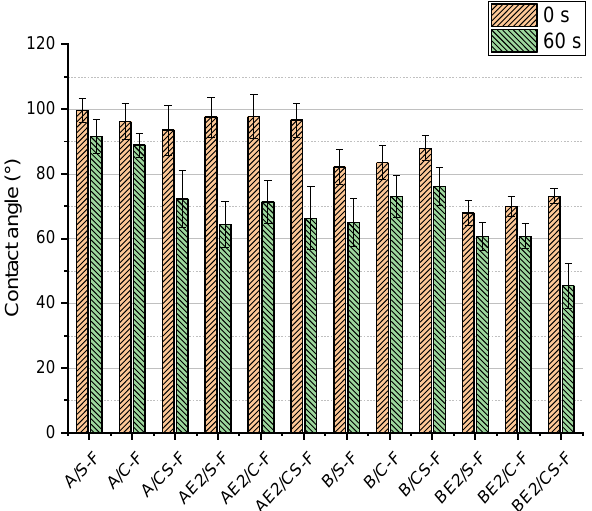
Figure 7. Contact angle values for the different bionanocomposite films at 0 s and 60 s. The error bars represent standard deviations.